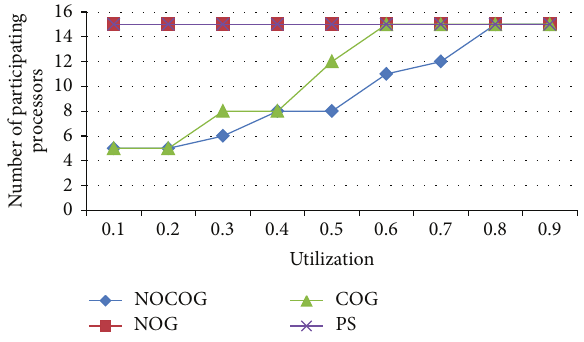
Figure 6: Number of participating processors versus system load.